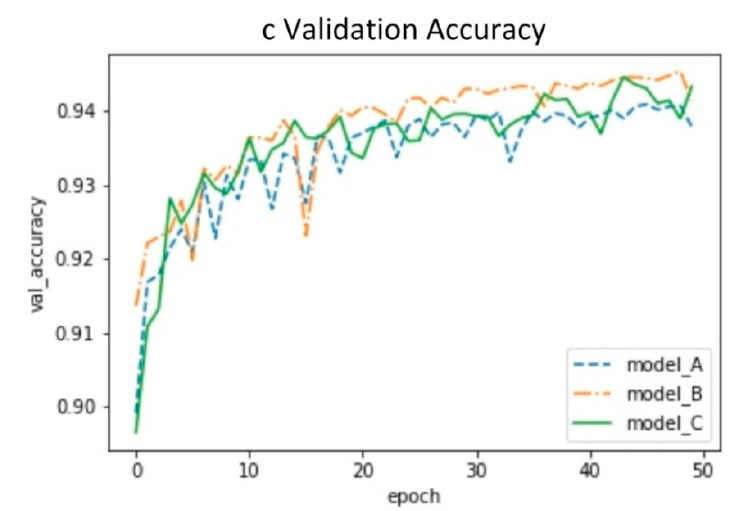
Figure 8. DTM results after terrain corrections. ( a ) training loss, ( b ) training accuracy, and ( c ) validation accuracy of the three different network structures, with different epoch settings.